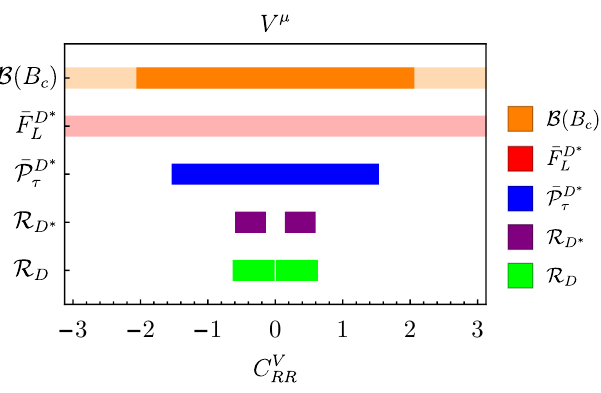
Figure 3 . Fit-independent plot of Scenario 3 . Dark colours indicate the allowed regions satisfying the experimental constraints at 1 (cid:27) and the 10% upper limit on B ( B c ! (cid:28) (cid:22) (cid:23) ), for a given value of C V . There is no allowed region for (cid:22) F D (cid:3) at 1 (cid:27) . The lighter orange and red shaded areas correspond RR L to the more relaxed 30% bound on the leptonic B c decay and the 2 (cid:27) region for (cid:22) F D (cid:3)